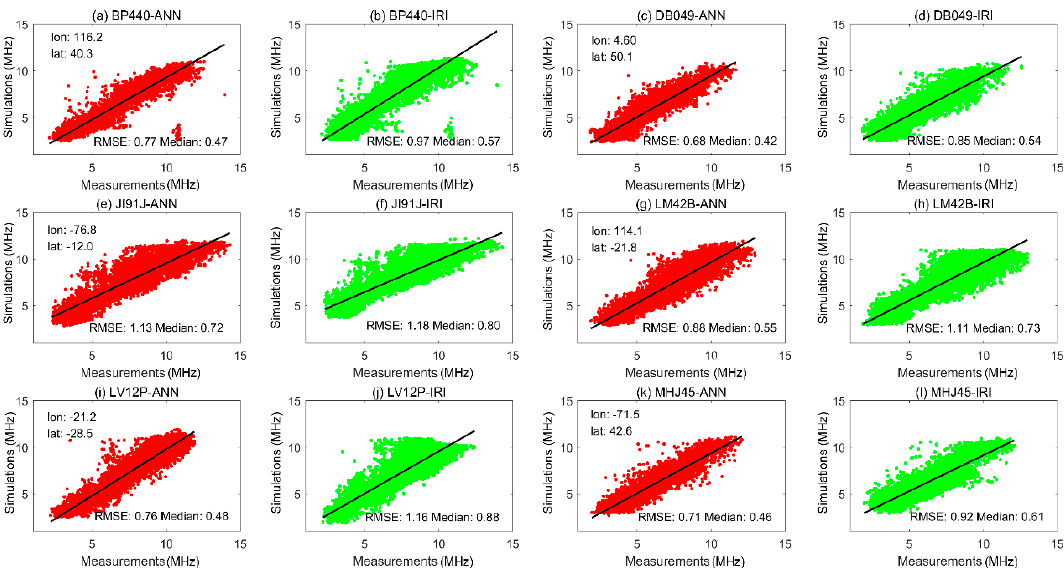
Figure 6. Comparison of the accuracies between Global Ionospheric Peak Frequency Model (GIPFM) and International Reference Ionosphere (IRI) in 2013.